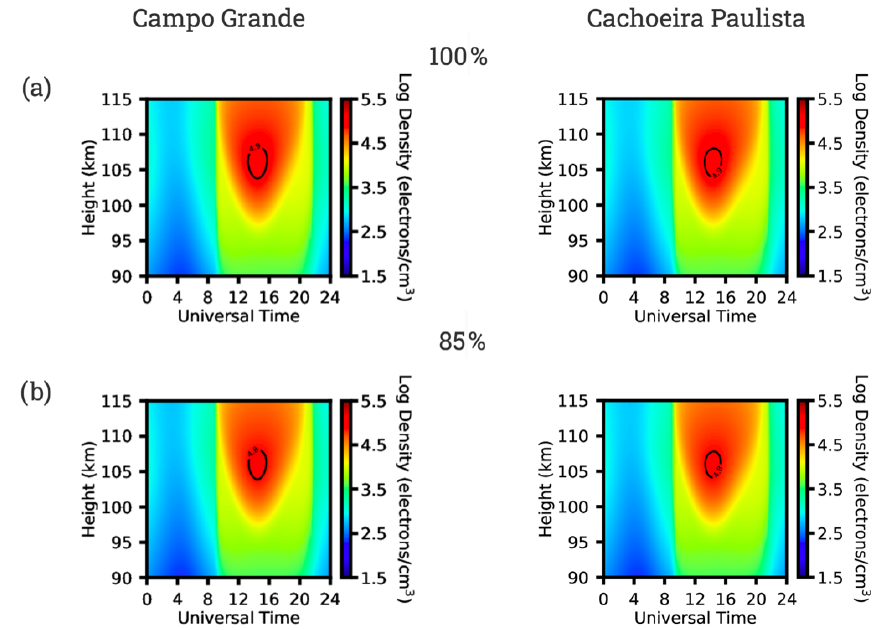
Figure 9. E region electron density simulated by MIRE considering the ionization for (a) 100% and (b) 85% on 14 December 2020, in Campo Grande (left panel) and Cachoeira Paulista (right panel).